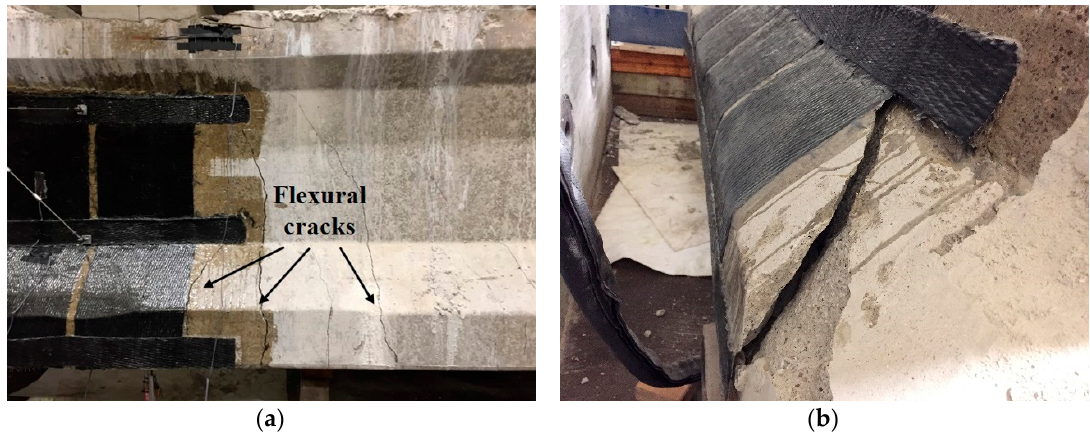
Figure 10. Failure mode of the CFRP case: ( a ) flexural cracks under loading point (1:27) and ( b ) large cracking above bearing plate (1:10).